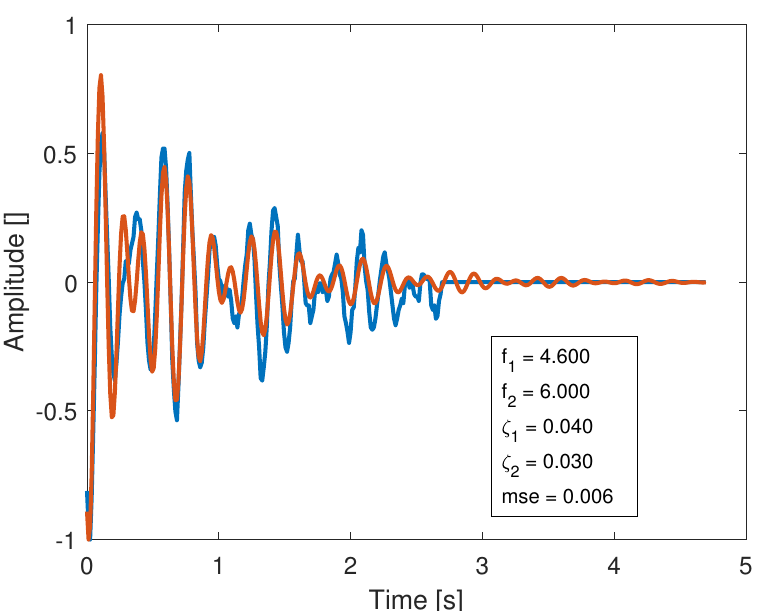
Figure 18. Original signal (blue) and signal reconstruction processed by the Laplace Wavelet tech- nique (red). MSE order 22 (lower order means better